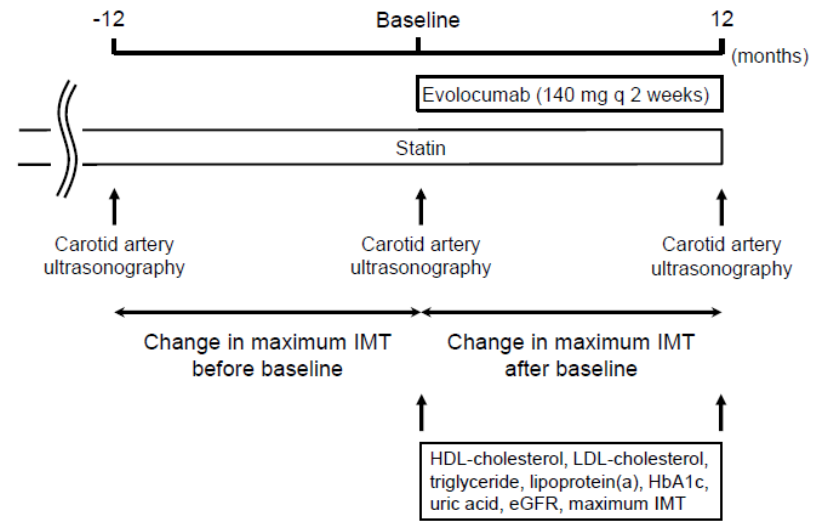
Figure 1. Study design.